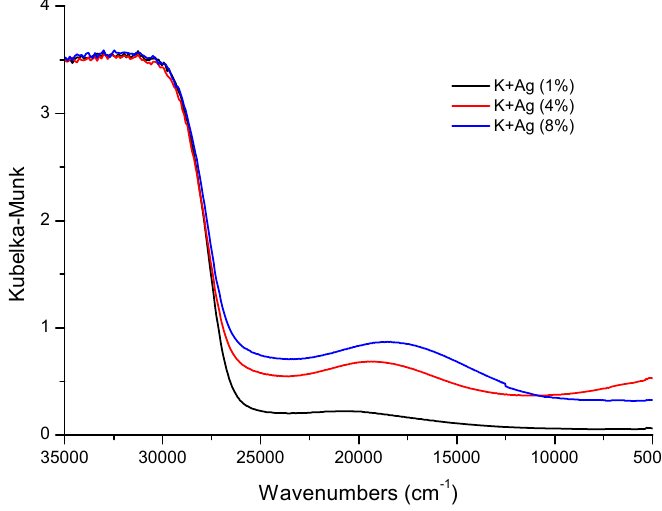
Figure 3. UV-diffuse reflectance spectroscopy (DRS) spectra of as-prepared AgNPs–TiO 2 .